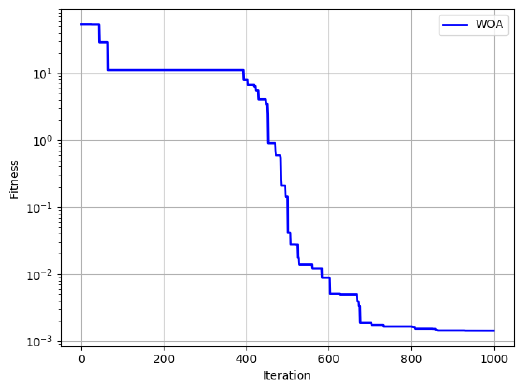
Figure 8. WOA corrected end position error curve.